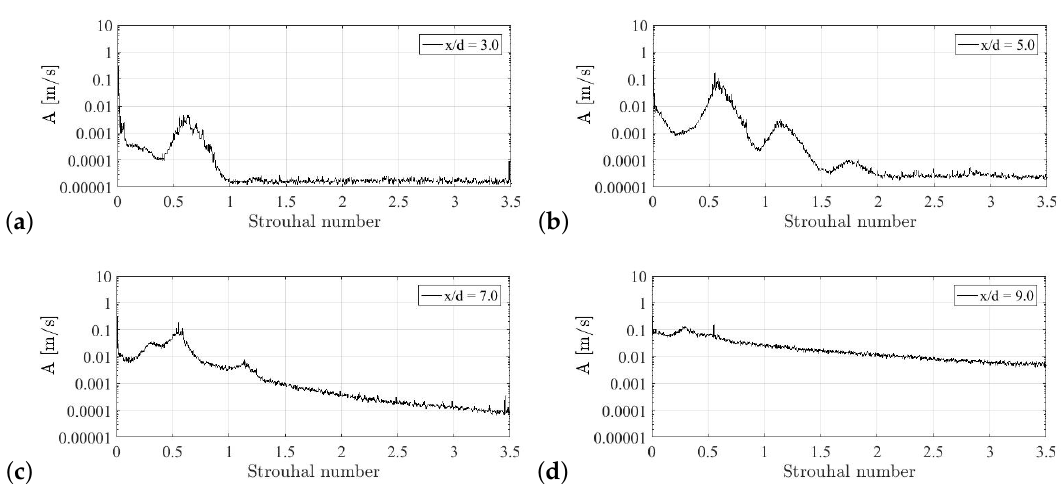
Figure 3. Evolution of spectra of axial velocity fluctuations, S = 0.9, L / D = 7, Re = 5000: ( a ) x / D = 3, ( b ) x / D = 5, ( c ) x / D = 7, ( d ) x / D =